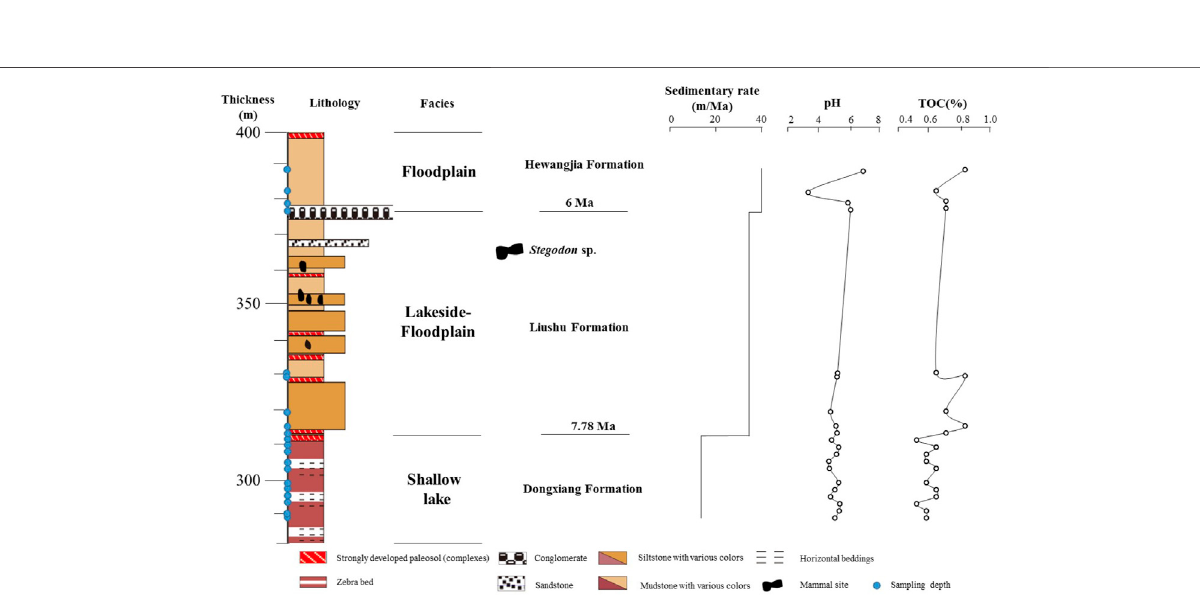
Frontiers in Earth Science |